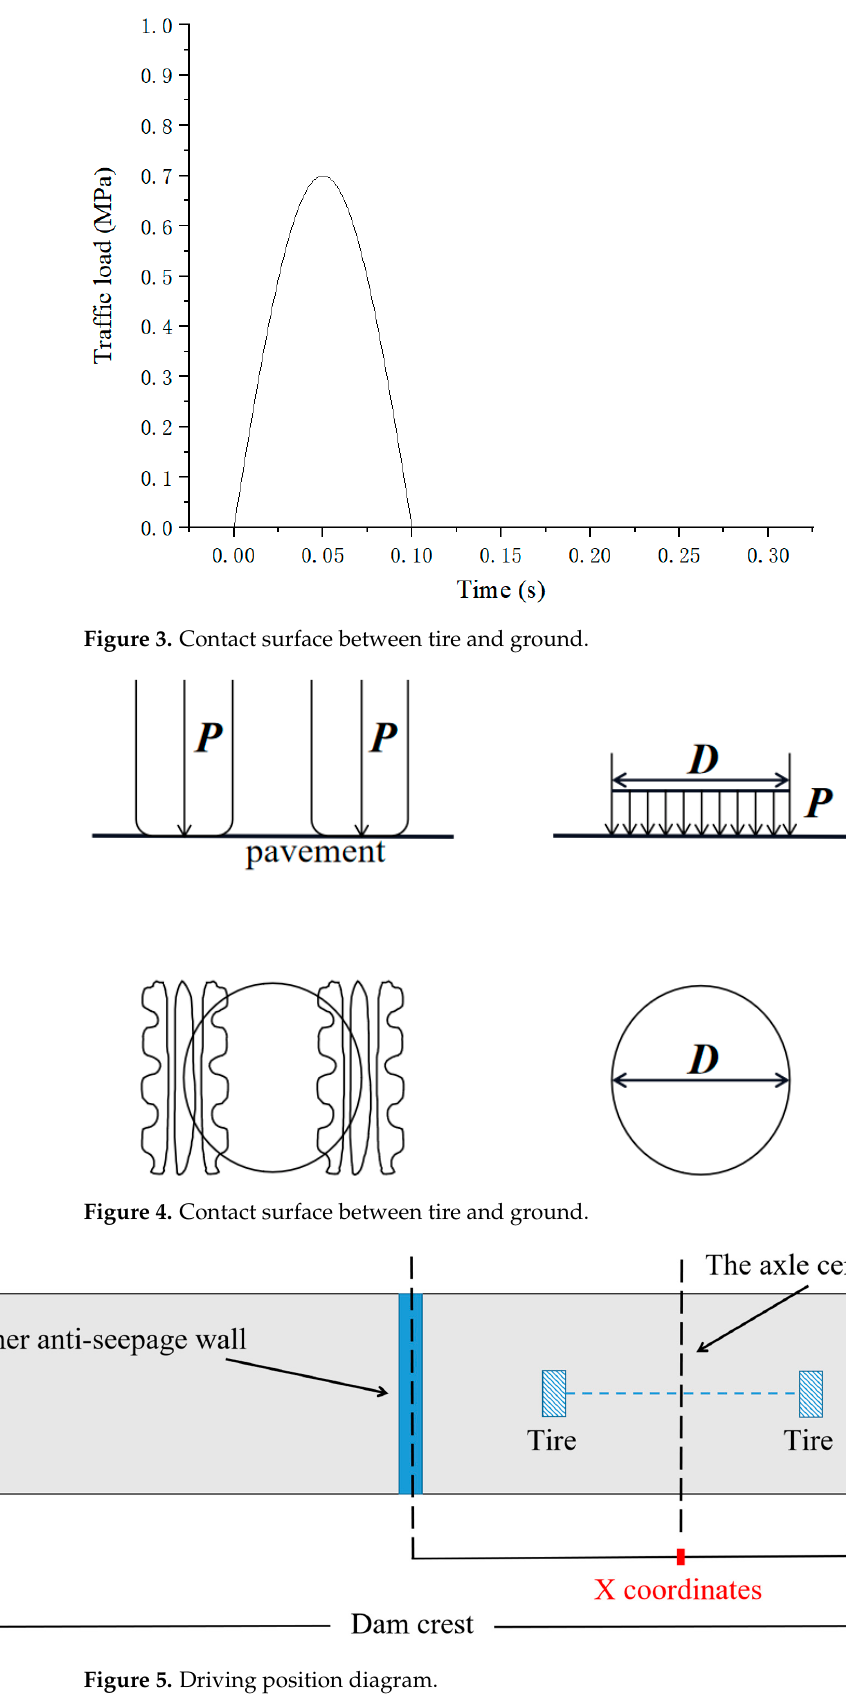
Figure 5. Driving position diagram.